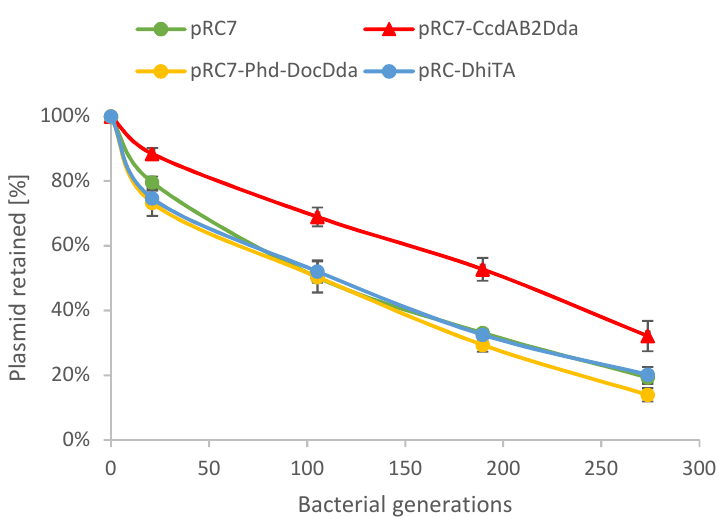
Figure 8. D. dadantii 3937 toxin-antitoxin system ccdAB 2Dda improves plasmid maintenance in E. coli K-12 MG1655 ∆ lacZ strain. Stability assays were conducted with derivatives of the stability probe vector, pRC7: pRC7 does not contain any accessory stability determinants (green), pRC7-ccdAB 2Dda contains the ccdAB 2Dda cassette (red), pRC7-phd-doc Dda contains the phd-doc Dda cassette (yellow), and pRC7-dhiTA contains the dhiTA cassette (blue). Generation time corresponds to 17.1 min [39]. Results are an average of at least three independent experiments with SD indicated, and 100% represents the sum of plasmid-harbouring and plasmid-less CFU. To assess statistical significance of the obtained results analysis of covariance (ANCOVA) and HSD Tuckey post-hoc test were applied.